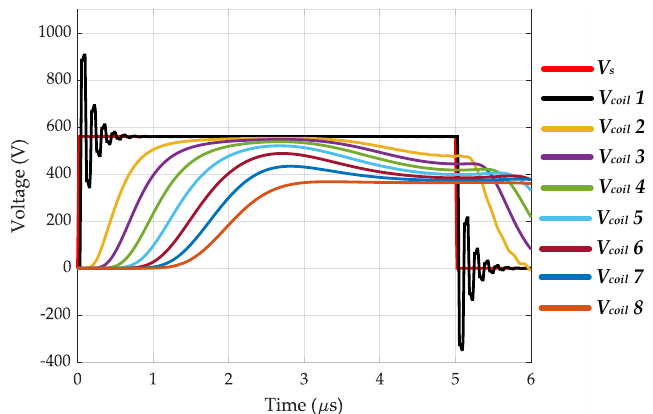
Figure 23. Coil-to-core voltages of different coils when a three-phase model is implemented and only one phase is excited by a 560 V PWM voltage with 𝑡 𝑟 = 20 ns and the neutral point is floating.